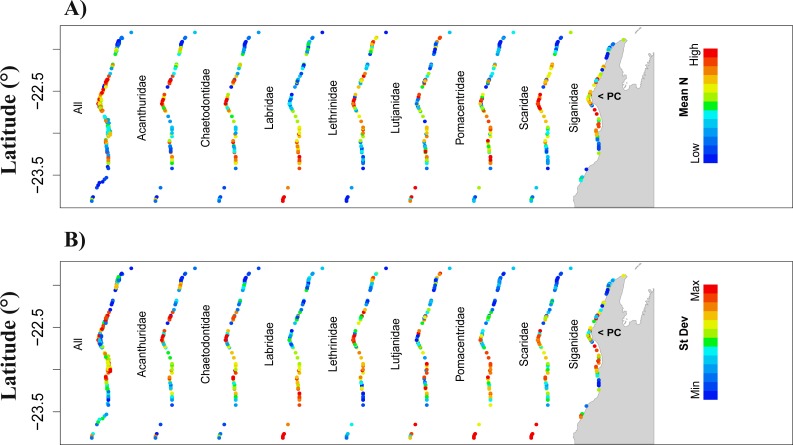
Prediction of total fish abundance (Ntotal) and fish abundance by fish family (Nfam) at Ningaloo Reef (NR) by the reference NR model.Predictions for locations where predictor values were within the range of values used during model calibration with (A) showing only the mean prediction values for abundance and (B) showing the standard error associated with each mean predicted value. The same colour scheme applies to all maps in each row (for high, low, maximum and minimum prediction values refer to Table 4). Results not shown for fish families for which the null model got highest wAICc support (refer to Table 4). Grey area represents the Northwest of Western Australia, longitude: 113.7° to 114.5°E.